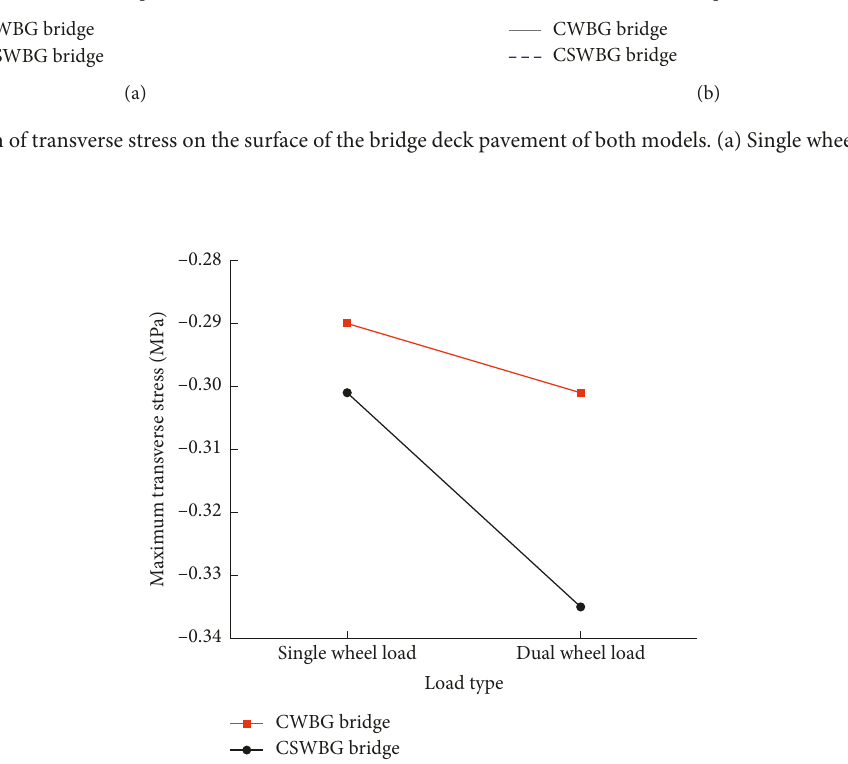
Figure 10: Comparison of maximum transverse stress on the surface of the bridge deck pavement at the same